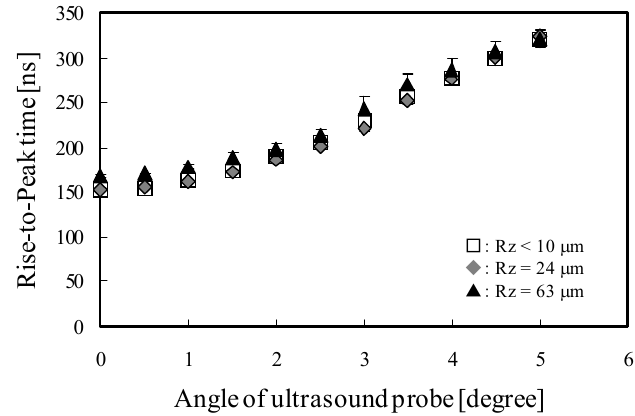
Figure 10: Relationship between Rise-to-Peak time and probe angle for the acrylic plates